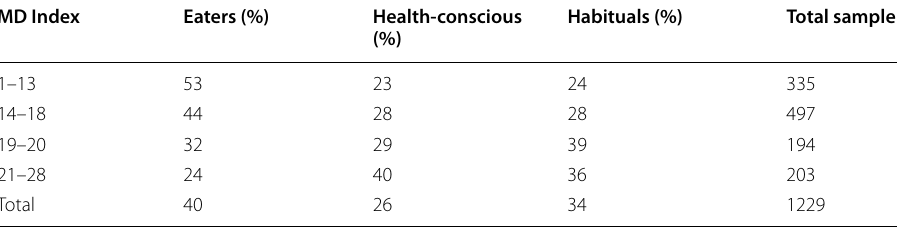
Table 6 Classes of observance of the Mediterranean diet (MD Index) in the three clusters before the pandemic